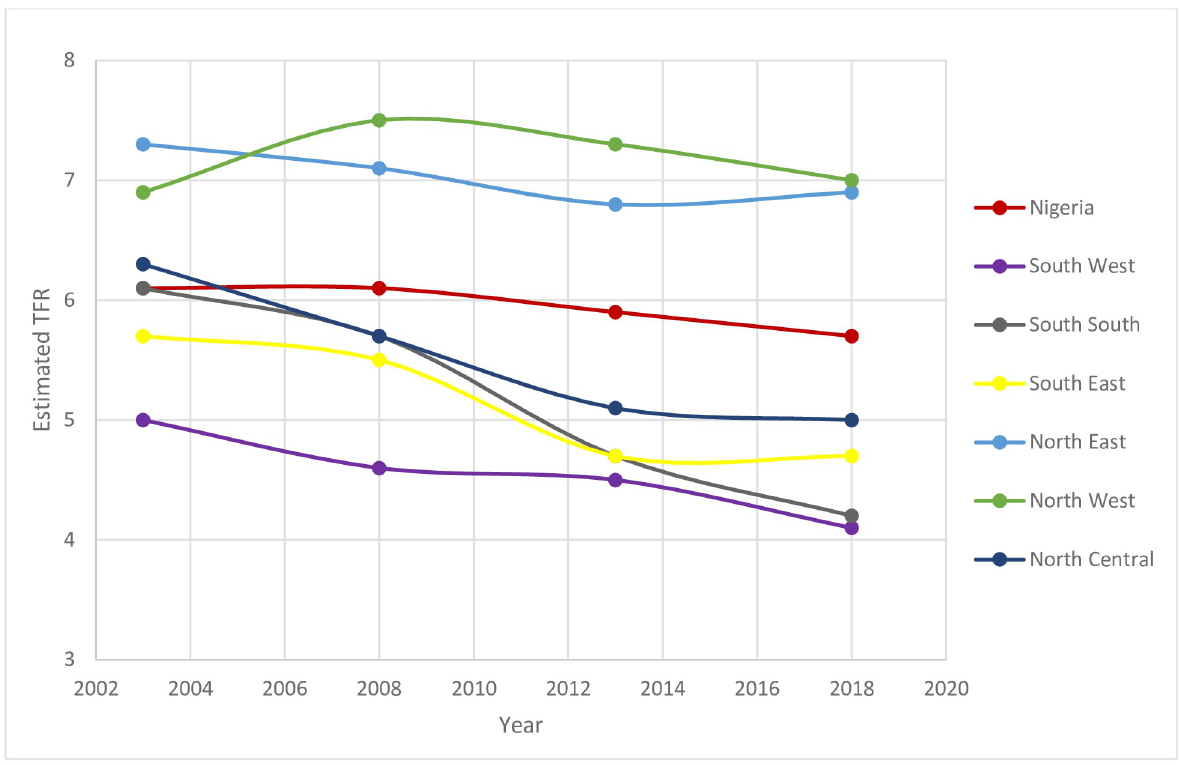
Fig 3. Trend in estimated total fertility rates by Nigeria and regions